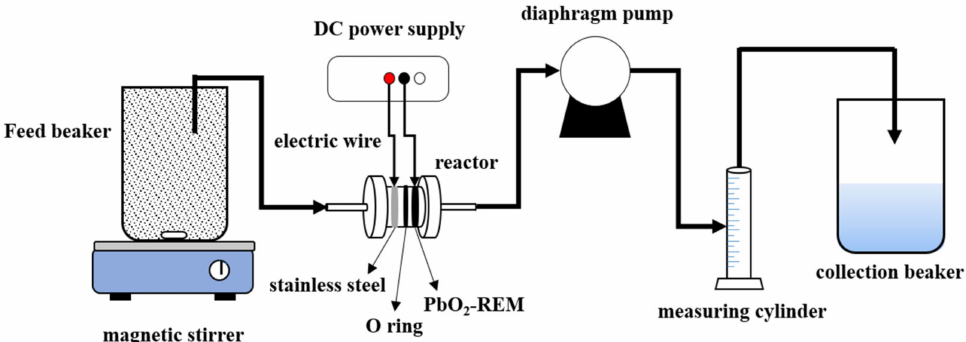
Figure 1. Schematic diagram of PbO 2 -REM and system for the